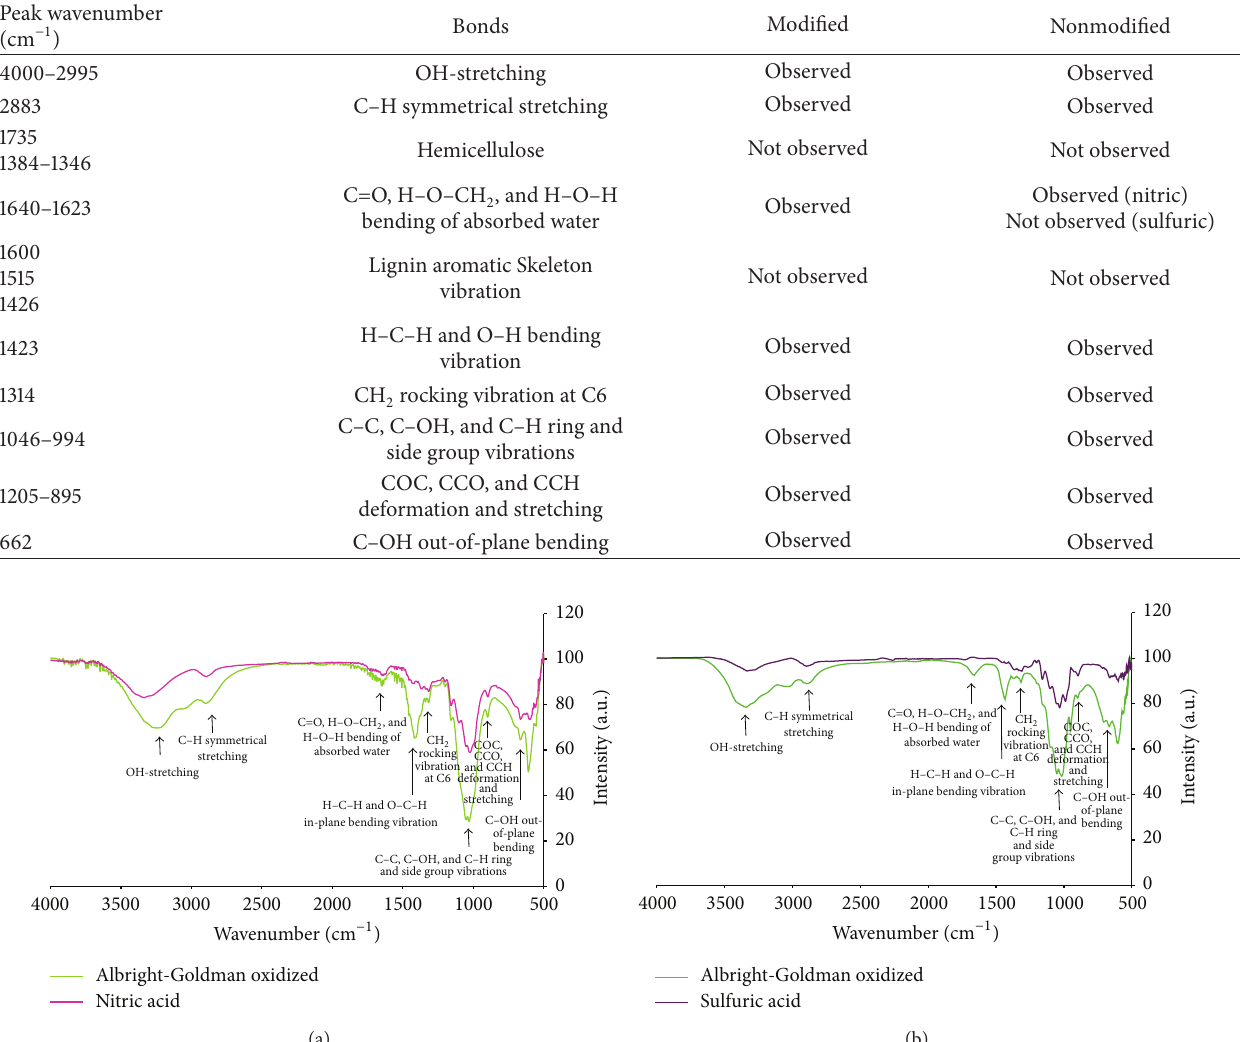
Table 2: The peak wavenumber and the corresponding bonds of cellulose [14].